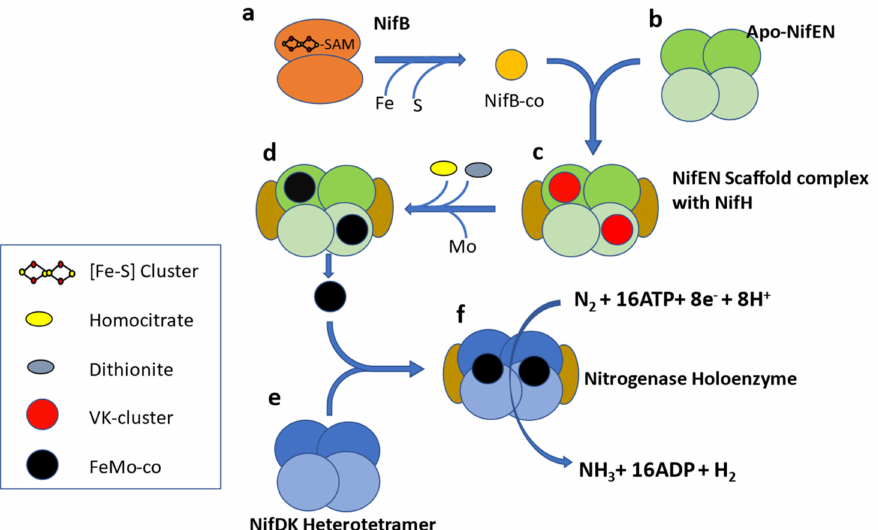
Figure 1. Schematic representation of FeMo-co biosynthesis. NifB ( a ) is a homodimer and belongs to the SAM radical protein family. NifB supplies homocitrate and Mo free, Fe-S cluster (precursor of Fe-Mo cofactor) to the Apo-NifEN heterotetramer ( b ). NifEN is homologous to NifDK and acts as molecular scaffold for assembly of Fe-Mo cofactor along with NifH ( c , d ). The assembled Fe-Mo cofactor is transferred to the Nitrogenase apoenzyme ( e ), which forms the nitrogenase holoenzyme ( f ) along with NifH. NifH has a role in both assembly of the Fe-Mo cofactor as well as reduction of dinitrogen